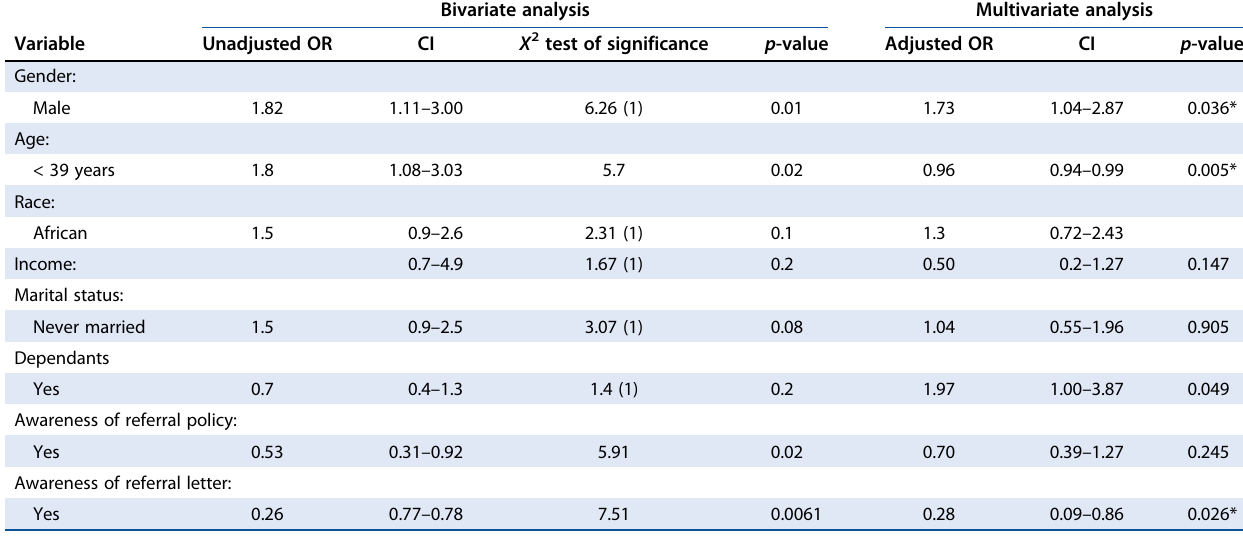
Table 3: Bivariate and multivariate analyses assessing participant factors ( n = 315) and self-referral in eThekwini district and district/regional hospitals between May and June 2015